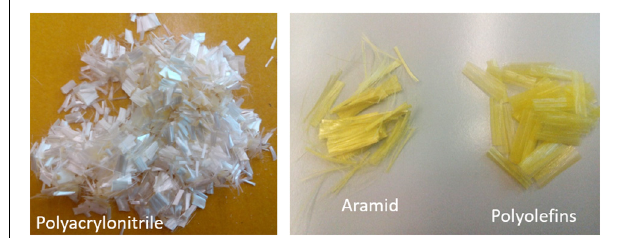
FIGURE 1 | Images of the different fibers evaluated. Type P (left) and type A (right) .